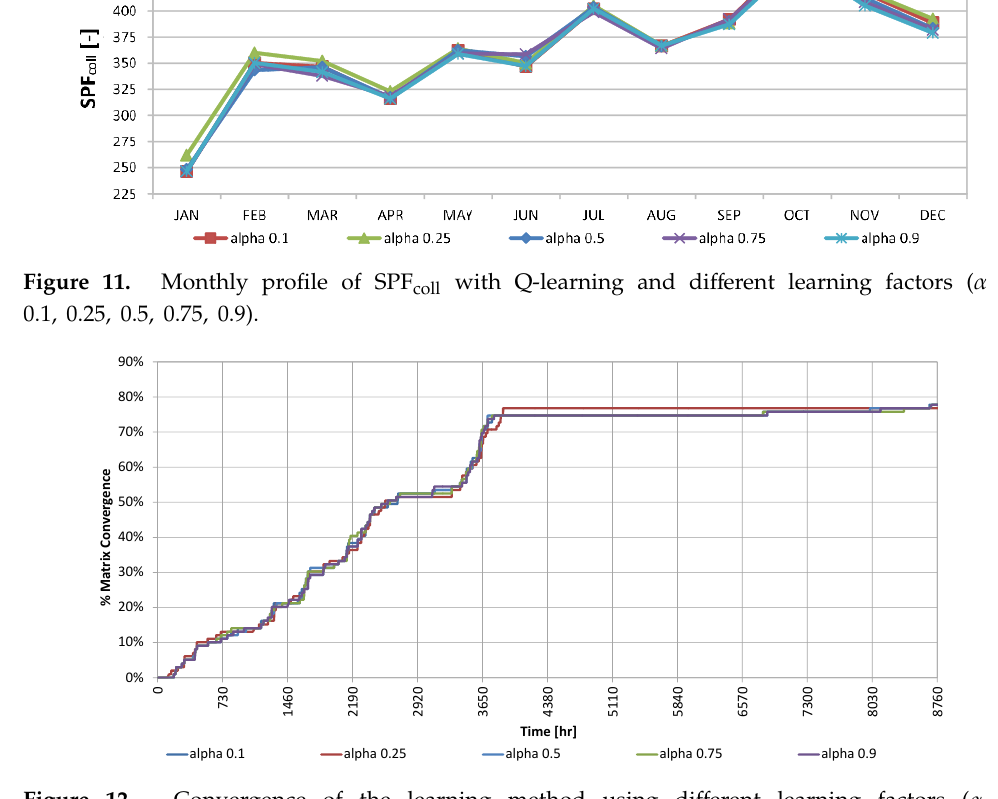
Figure 13. Monthly profile of the SPF coll with Q-learning and different parameters gamma.